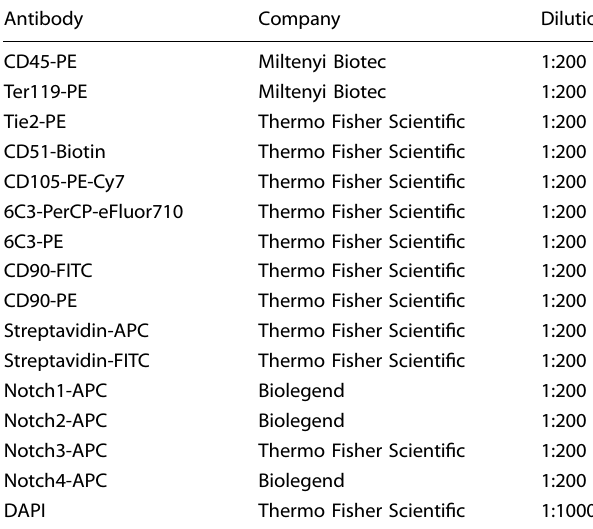
Table 1. Antibodies for fl ow cytometry. Table 2. PCR